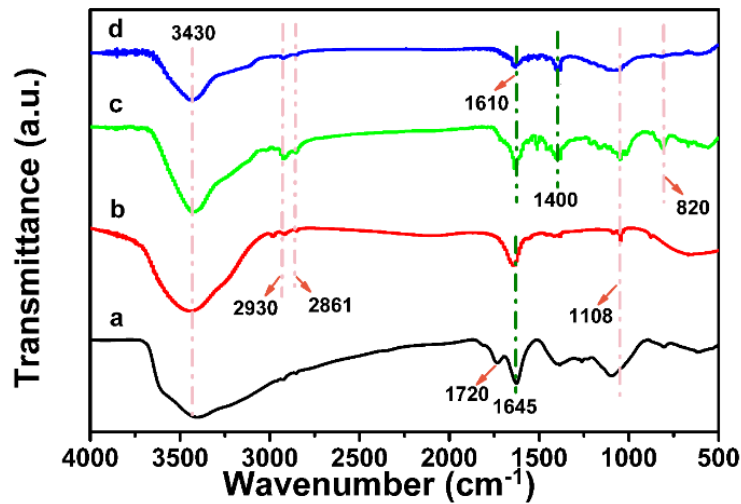
Figure 1. FTIR spectra of ( a ) GO, ( b ) GO-DDAT, ( c ) Co-GHCP, and ( d ) Co-GPC.